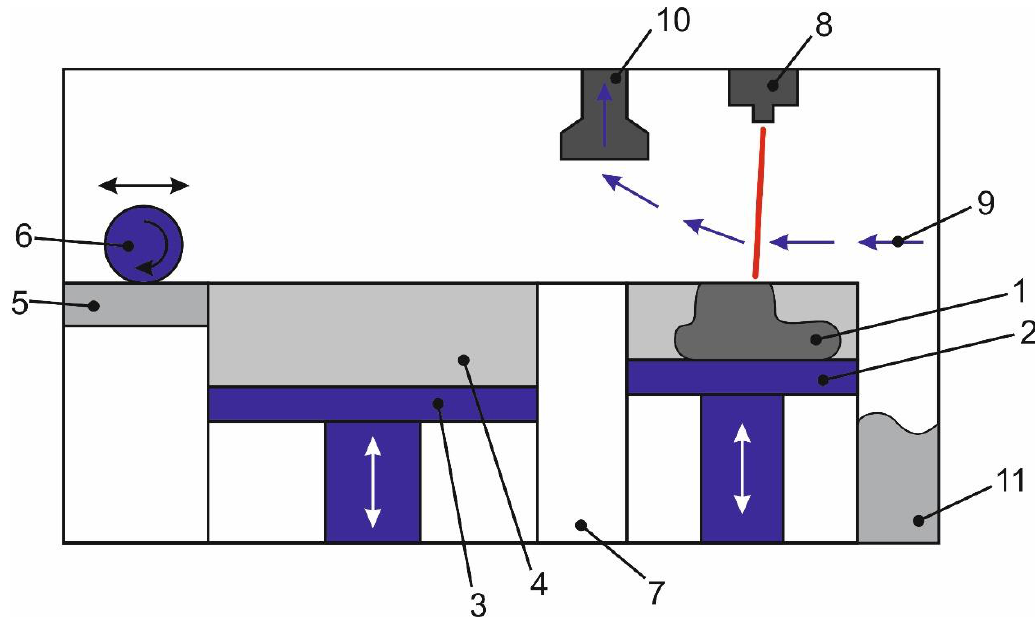
Figure 3. The scheme of the working chamber ProX 300: 1—Product, 2—product growing platform, 3—metal powder feeding platform, 4—metal powder, 5—area for cleaning the roller from powder, 6—roller for applying powder, 7—a partition between the construction zone and the powder storage hopper, 8—optical laser beam control system, 9—blowing gas, 10—output of combustion products, 11—storage bin for excess powder.